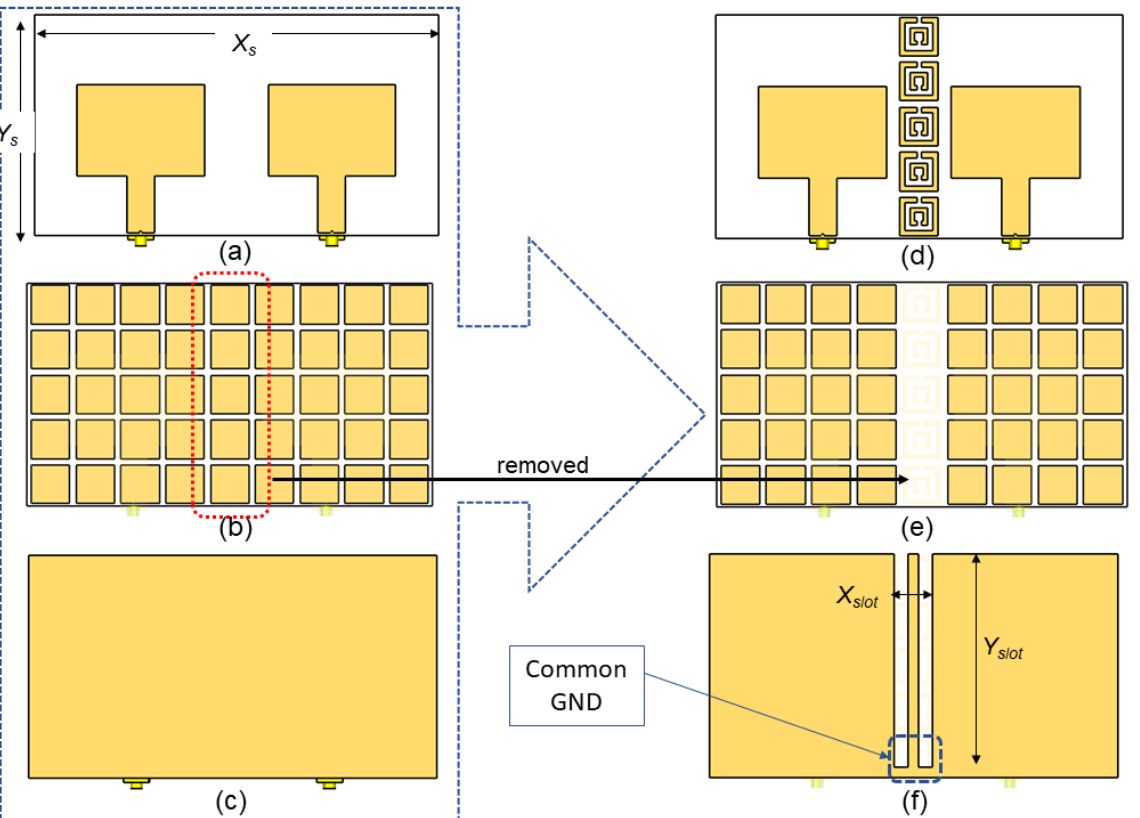
Figure 5. MIMO antenna using RIS: ( a ) front view, ( b ) second layer and ( c ) ground plane; and MIMO antenna using RIS and EBG: ( d ) front view, ( e ) second layer and ( f ) ground plane.